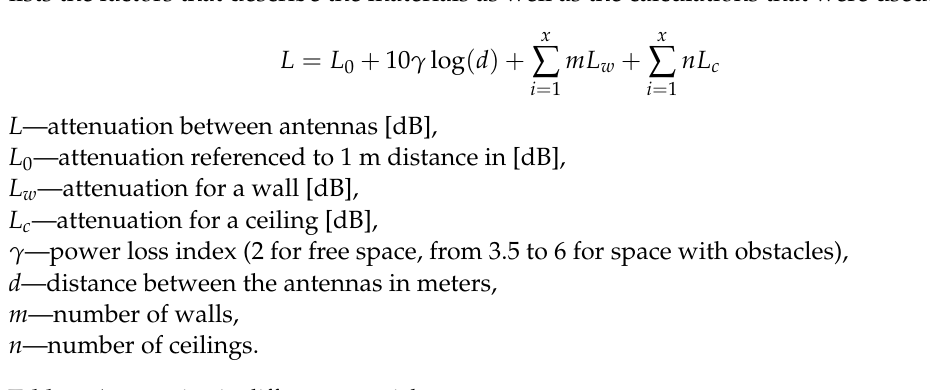
Table 1. Attenuation in different material